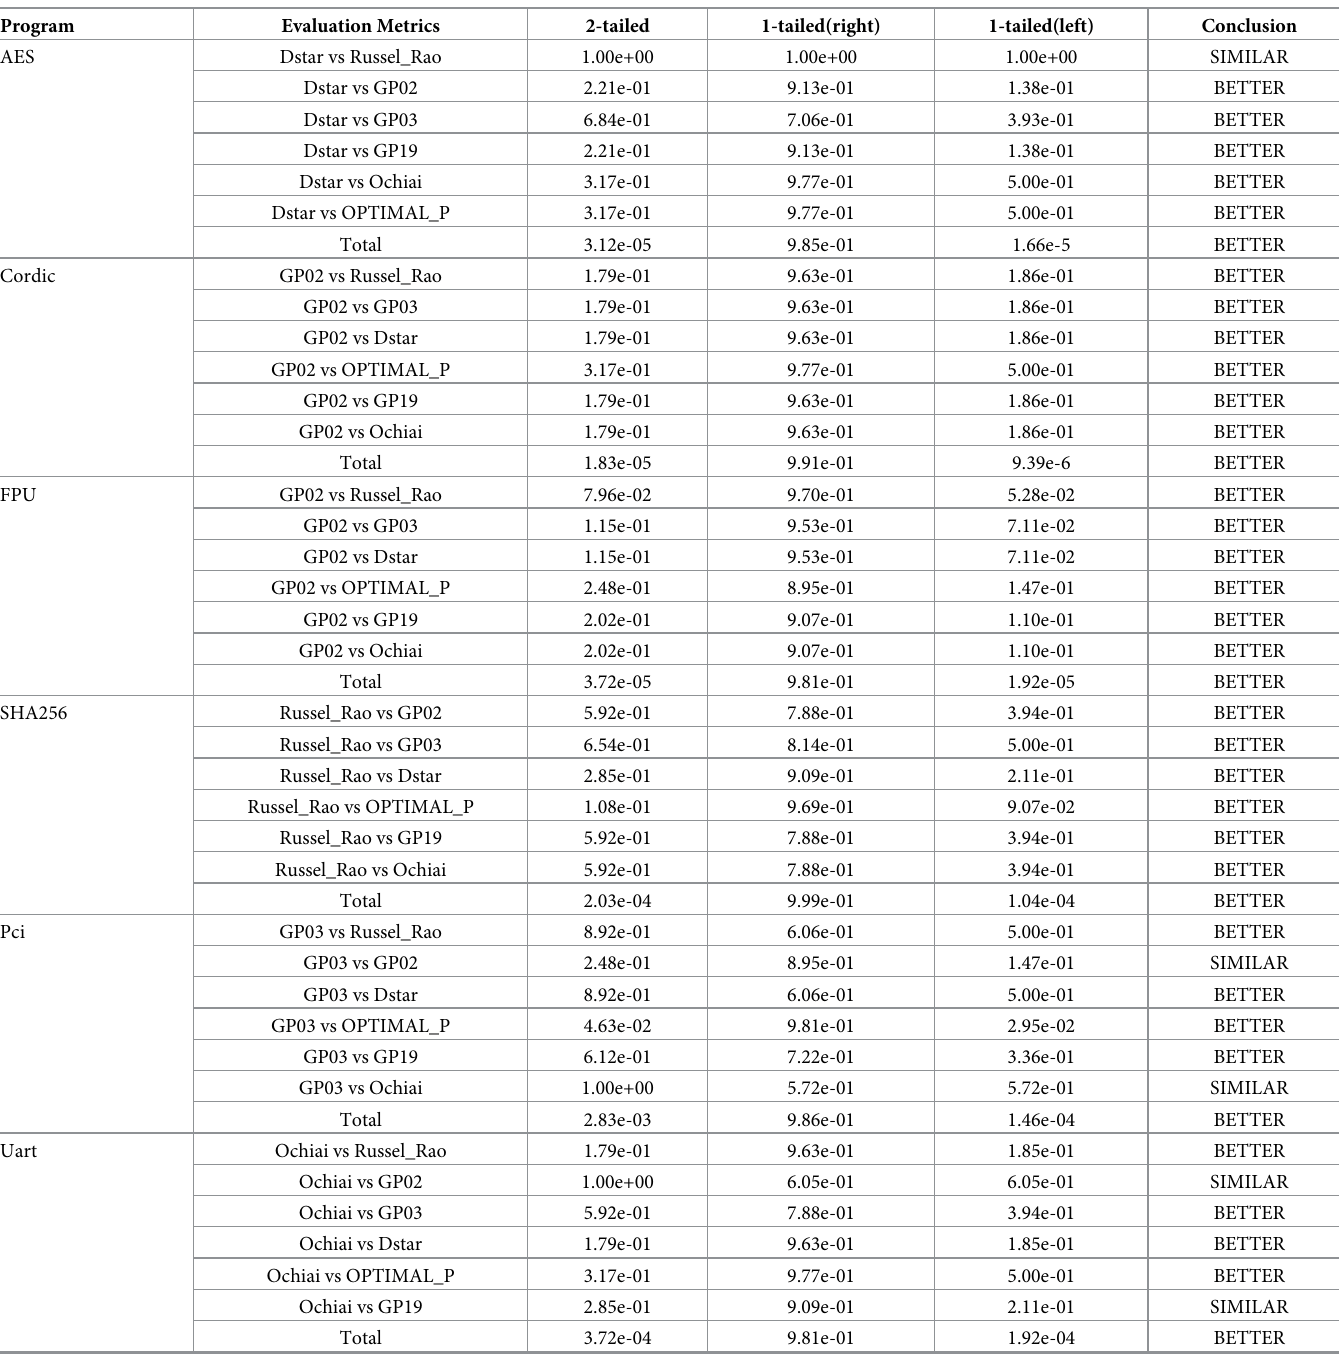
Table 5. Wilcoxon-Signed-Rank test of Detraque on seven